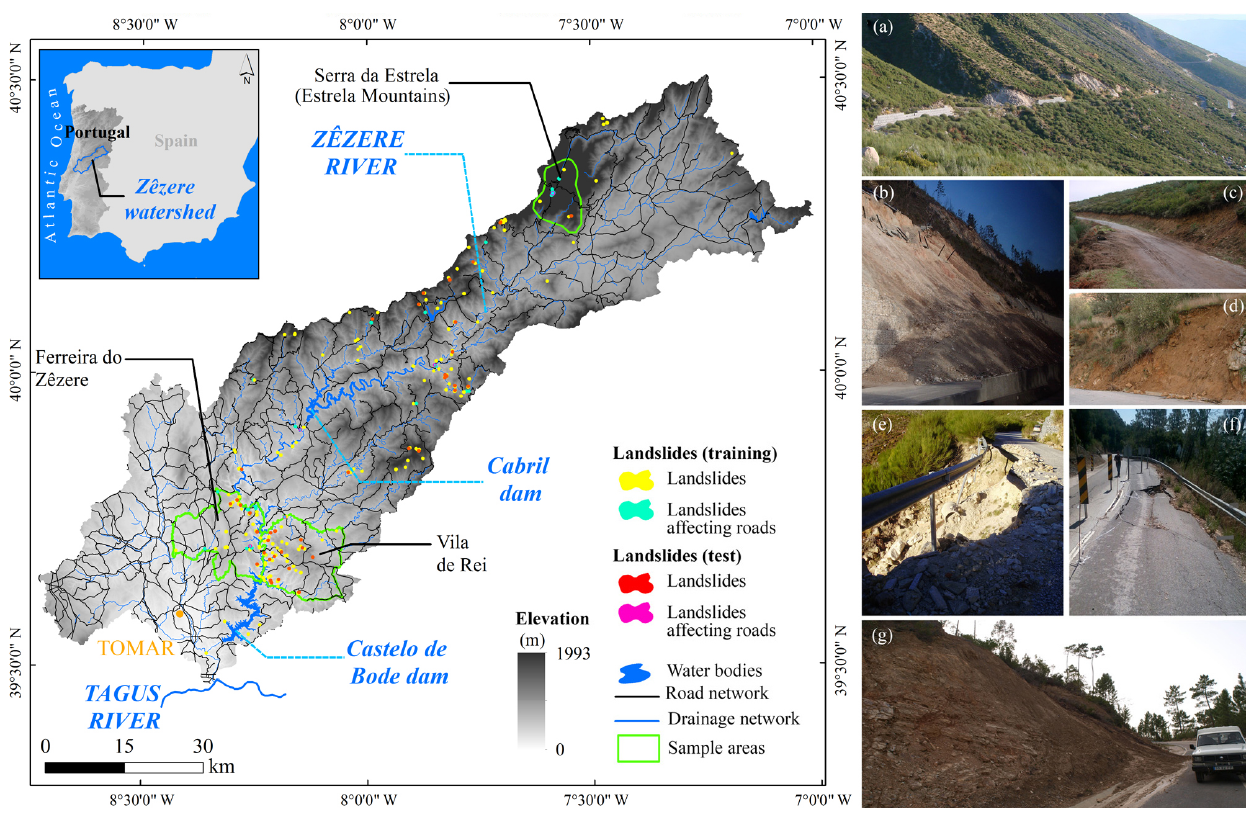
Figure 1. Zêzere watershed and landslide inventory. The pictures represent landslides that affected roads: A, B, C, D, and E – municipality roads of Serra da Estrela; F – Ferreira do Zêzere; G – Vila de